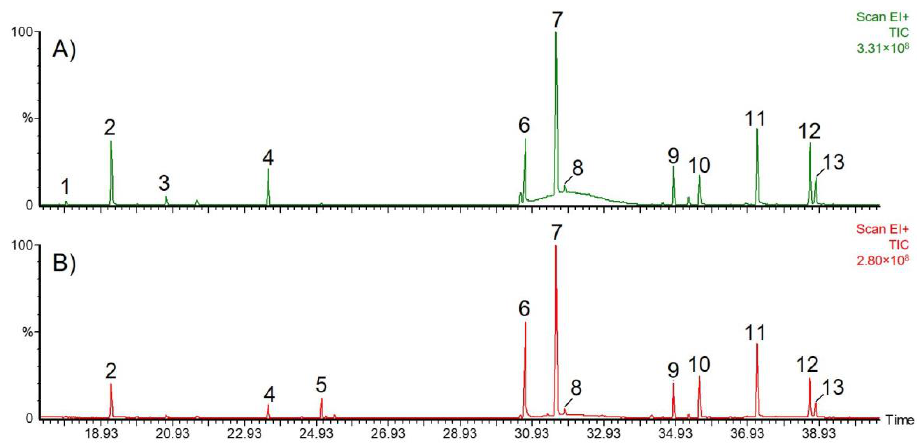
Figure 1. GC-MS total ion current chromatograms of M. recutita root dichloromethane extracts after silylation. Roots harvested ( A ) in March and ( B ) in June. Peak numbers refer to Table 1. Table 1. Volatile compounds in M. recutita root DCM extracts assigned based on their GC-MS characteristics. Base peaks are displayed in bold .